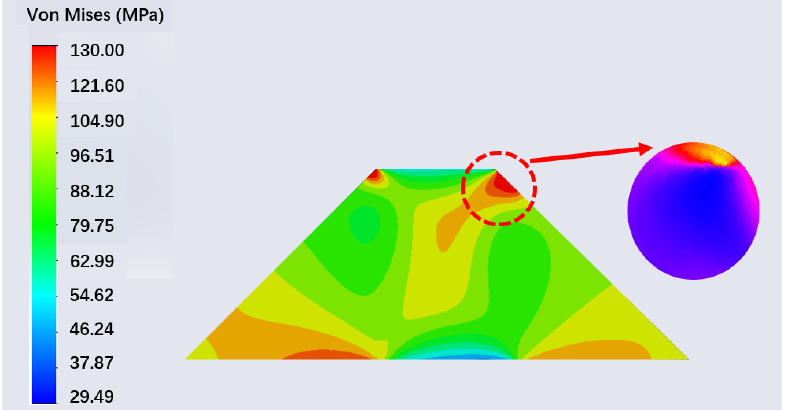
Figure 11. Mises stress diagram of sample.